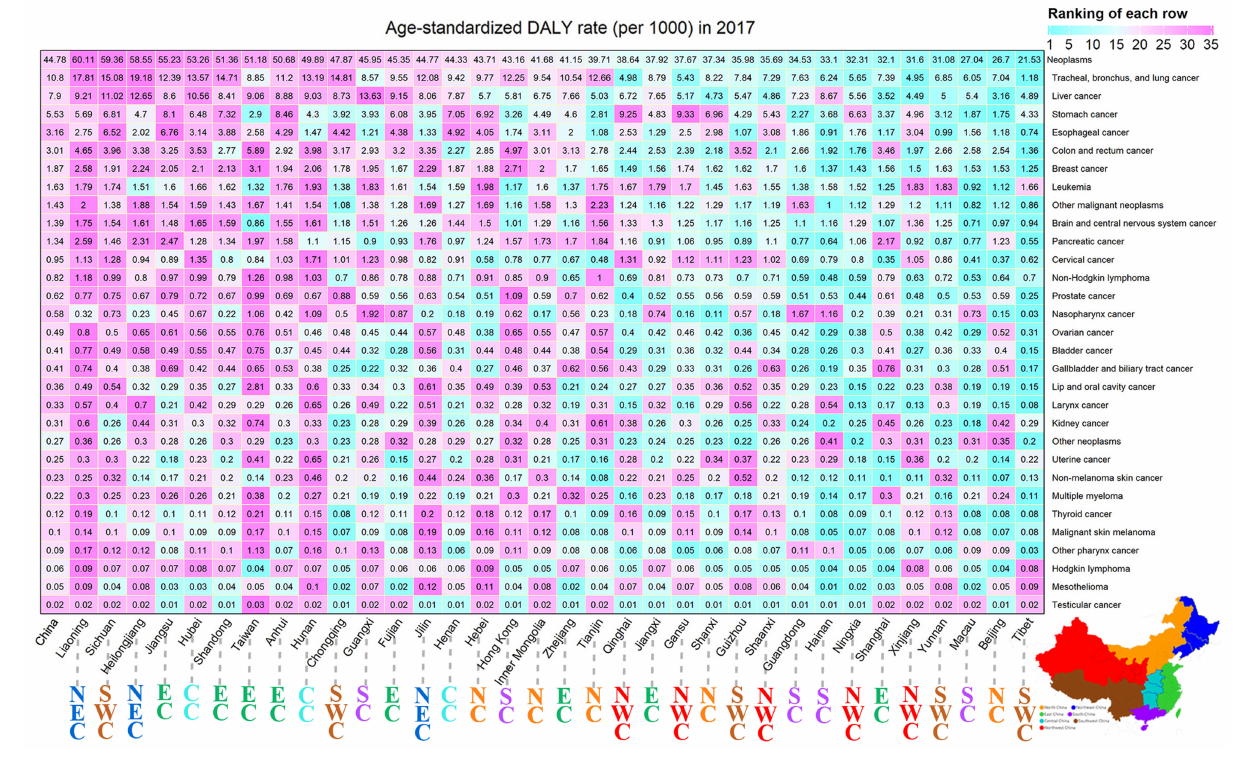
FIGURE 4 | The ASDR distribution of 36 neoplasm types in China and its 34 provinces in 2017, both. The color represents the ranking of each row (cyan is low and magenta is high). NC, North China; NEC, Northeast China; EC, East China; SC, South China; CC, Central China; SWC, Southwest China; NWC, Northwest